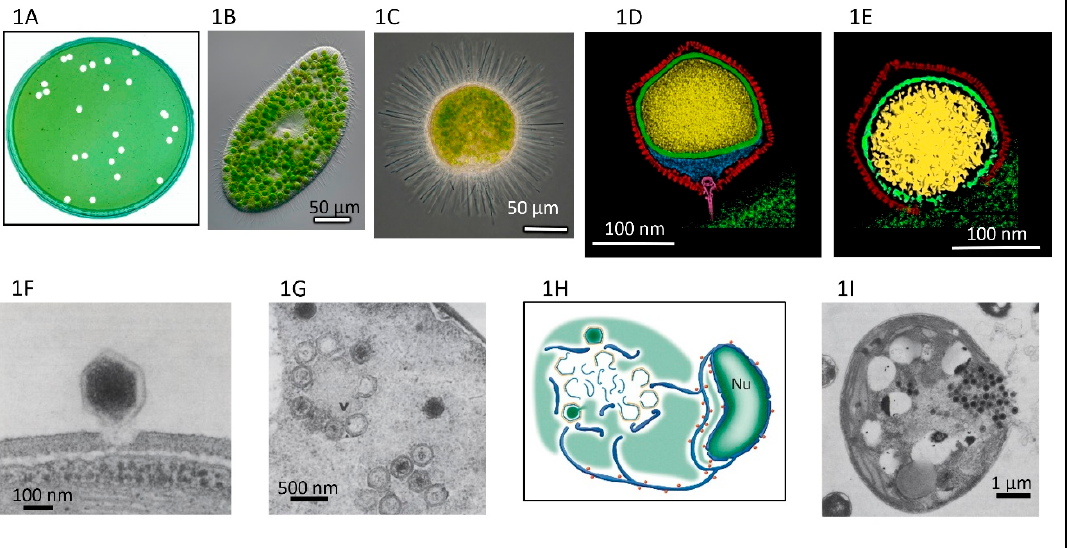
Figure 1. Chlorella cells and chlorovirus Paramecium bursaria chlorella virus-1 (PBCV-1). ( A ) Plaques formed by PBCV-1 on a lawn of C. variabilis NC64A. ( B ) The ciliate Paramecium bursaria and its symbiotic chlorella cells. ( C ) The heliozoon Acanthocystis turfacea and its symbiotic chlorella cells. ( D ) Cross section of a five-fold averaged cryo-EM image of PBCV-1 reveals a long narrow cylindrical spike structure at one vertex and the viral internal membrane (green) surrounding the viral genome asymmetrically. ( E ) Cross-section of a five-fold averaged cryo-EM of PBCV-1 as the virus is getting ready to release its DNA into the host cell. ( F ) Attachment of PBCV-1 to the algal cell wall and degradation of the wall at the point of attachment. This occurs within 1–3 min post infection (p.i.). ( G ) PBCV-1 particles assemble in defined areas in the cytoplasm named virus assembly centers at ~5 h p.i. Note both DNA containing (dark centers) and empty capsids. ( H ) A model showing that the origin of the PBCV-1 internal membrane arises from nuclei-derived cisternae, which serve as precursors for the single bi-layered virus membrane. Note, the membrane serves as the template for the capsid structures to form virus particles. ( I ) Localized lysis of the cell plasma membrane and cell wall and release of progeny viruses at ~7 h p.i. Panels D and E are from the cover of J. Virology issue 17, 2012. ( F ) is from Meints et al. [46], ( G ) is from Meints et al. [47], ( H ) is from Milrot et al. [48] and ( I ) is from Meints et al. [18]. All the figures are published with